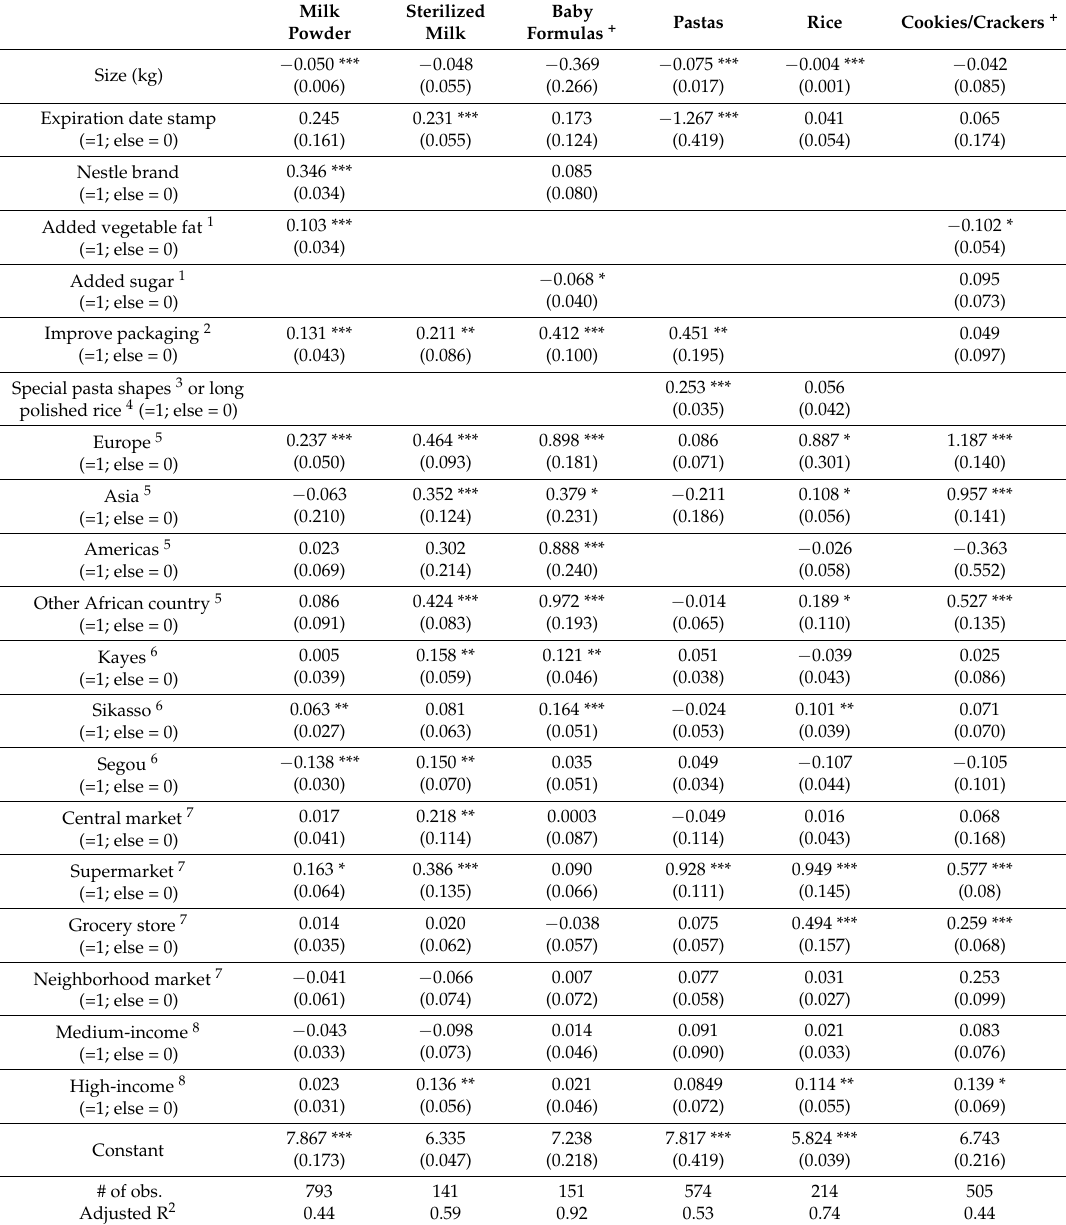
Table A2. Hedonic price regressions for processed dairy and grain products (ln FCFA/kg). Milk Sterilized Baby Pastas Rice Cookies/Crackers Powder Milk Formulas +